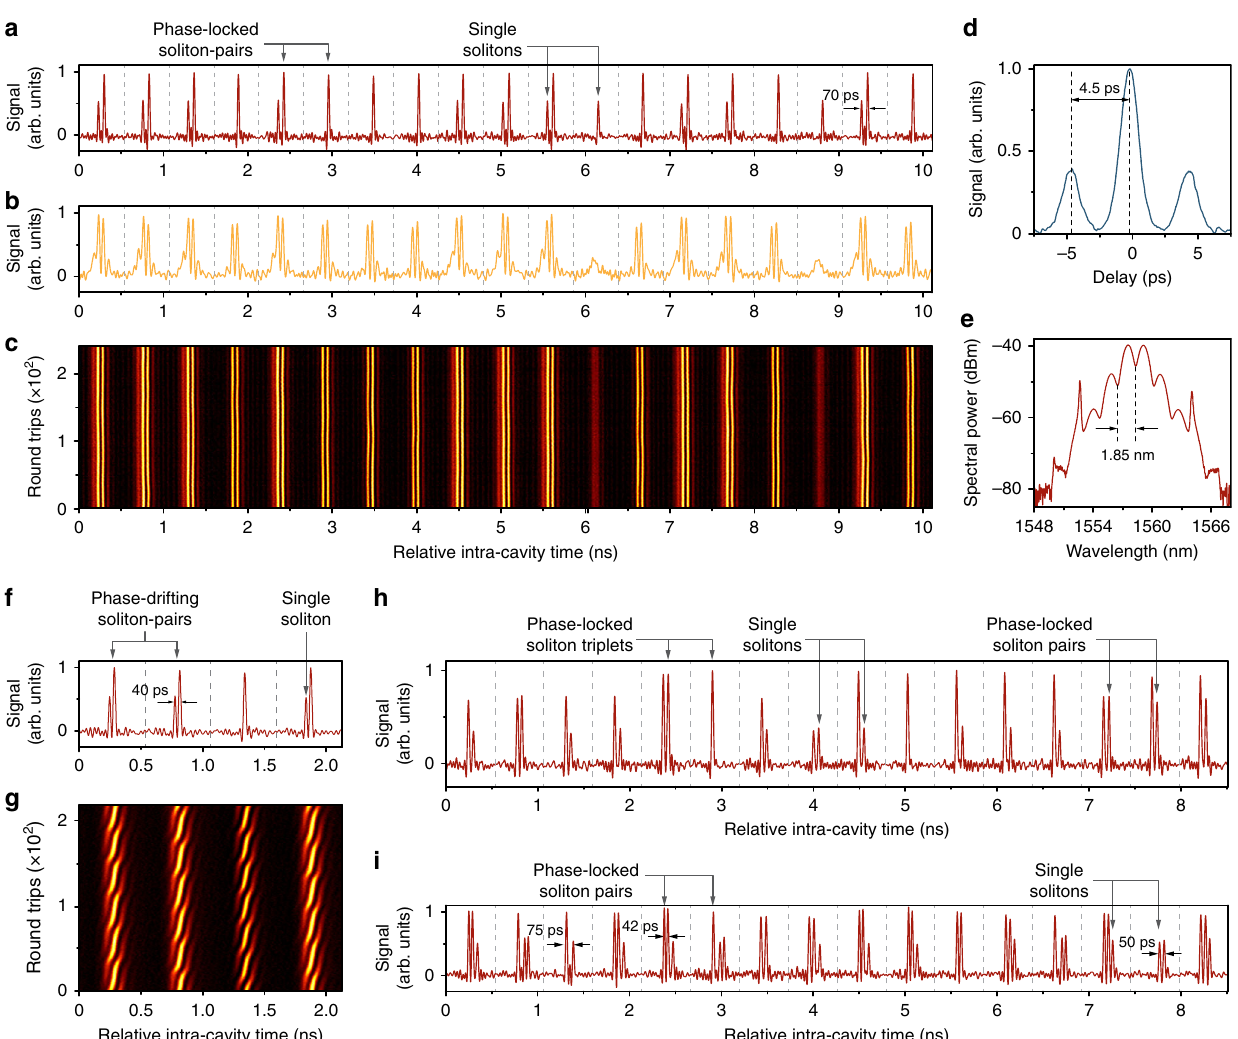
Fig. 3 Elementary diversity of the soliton supramolecules. a – c The time-domain trace ( a ) and TS-DFT signal ( b ) of a soliton supramolecule with both single solitons and soliton pairs as building blocks (only 19 out of 154 time-slots are shown). The persistence-mode plot in c con fi rms that the inner spacing and phase differences in the soliton pairs remain constant during the measurement. d , e Autocorrelation trace and optical spectrum of the soliton supramolecule. f, g Time-domain trace ( f ) and TS-DFT signal ( g ) of a soliton supramolecule with phase-sweeping soliton-pairs as one of its building blocks (only 4 out of 154 time-slots are shown). h Time-domain trace of a soliton supramolecule comprising single solitons, soliton pairs, and soliton triplets. i This complex supramolecule illustrates how the varying forces between dissimilar building blocks can lead to different inter-soliton spacings. Only 16 out of 154 time-slots are shown in 3e and 3